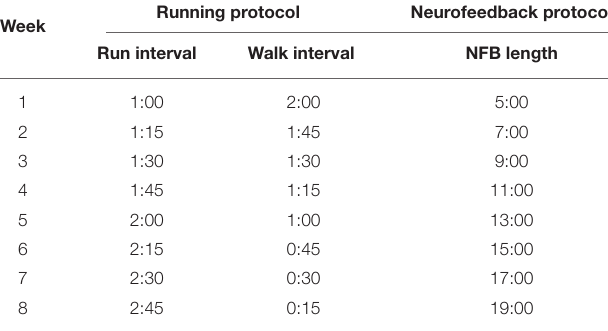
Each running session consisted of eight 3 min intervals, which were split into varying amounts of running and walking, as shown in the table. The difficulty of the running sessions increased every week by increasing the proportion of time spent running in each 3 min interval. In contrast, the NFB difficulty was increased by increasing the length of time the participants spent performing mindulness-like